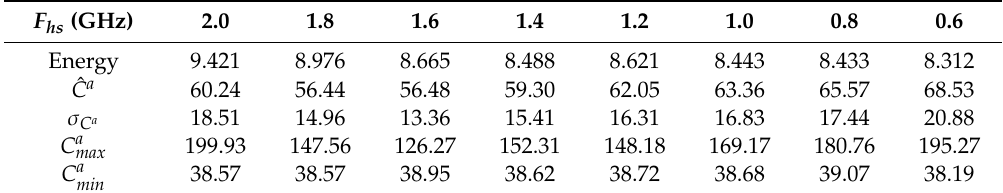
Table 13. Interactive governor with configuration 1 and di ff erent F hs values.